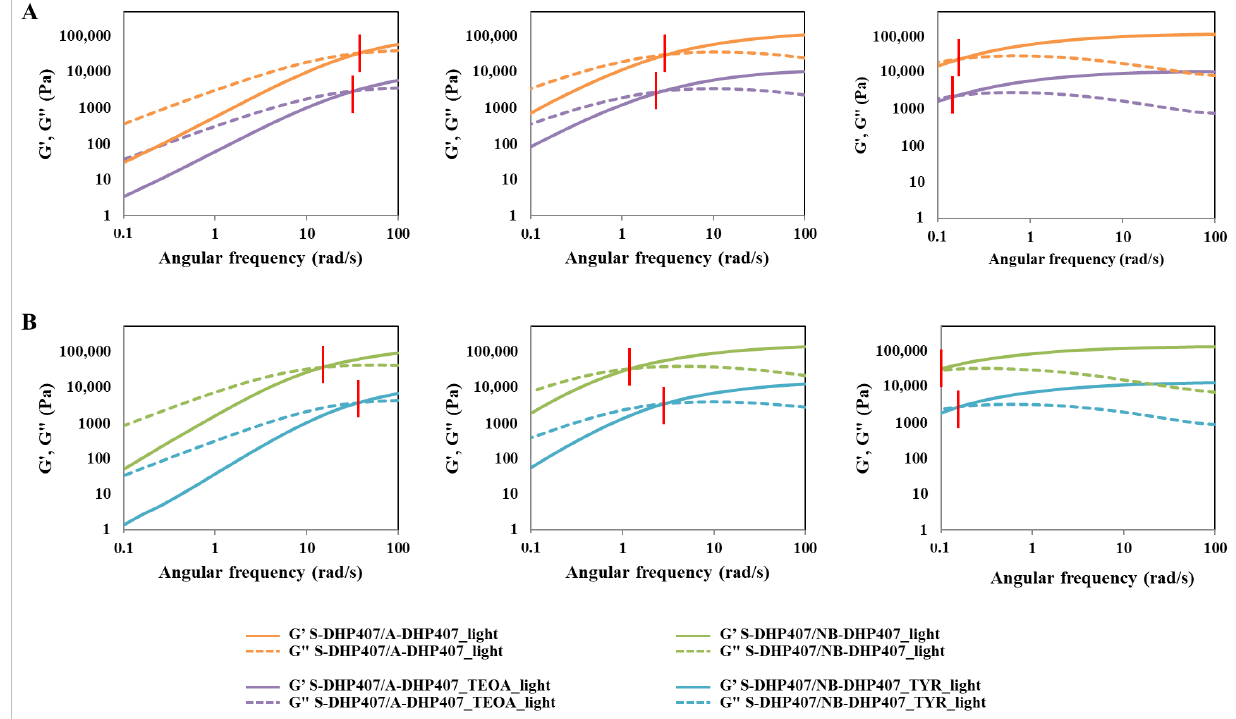
Figure 9. Frequency sweep tests performed at 25 °C, 30 °C and 37 °C (from left to right) on S- DHP407/A-DHP407 hydrogels ( A ) with and without TEOA (violet and orange, respectively) and S-DHP407/NB-DHP407 formulations ( B ) with and without TYR (light blue and green, respectively) after exposure to visible light (525 nm, 80,000 Lux, 10 min). For higher clarity, G’ and G” values of co-initiator-loaded formulations were divided by a factor of 10.